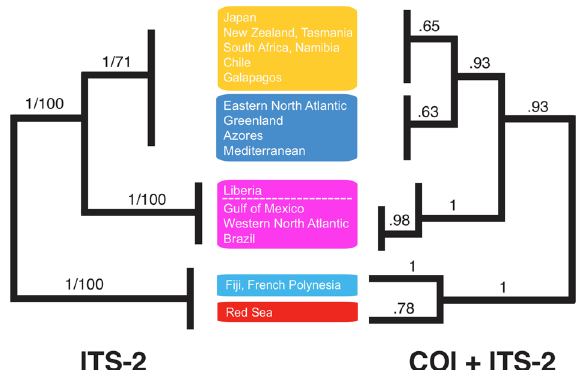
Figure 4. Topologies resulting from maximum-likelihood and Bayesian analyses of Maurolicus for ITS-2 and concatenated COI + ITS-2 data. Bootstrap support (ML) and Bayesian posterior probability values are indicated.